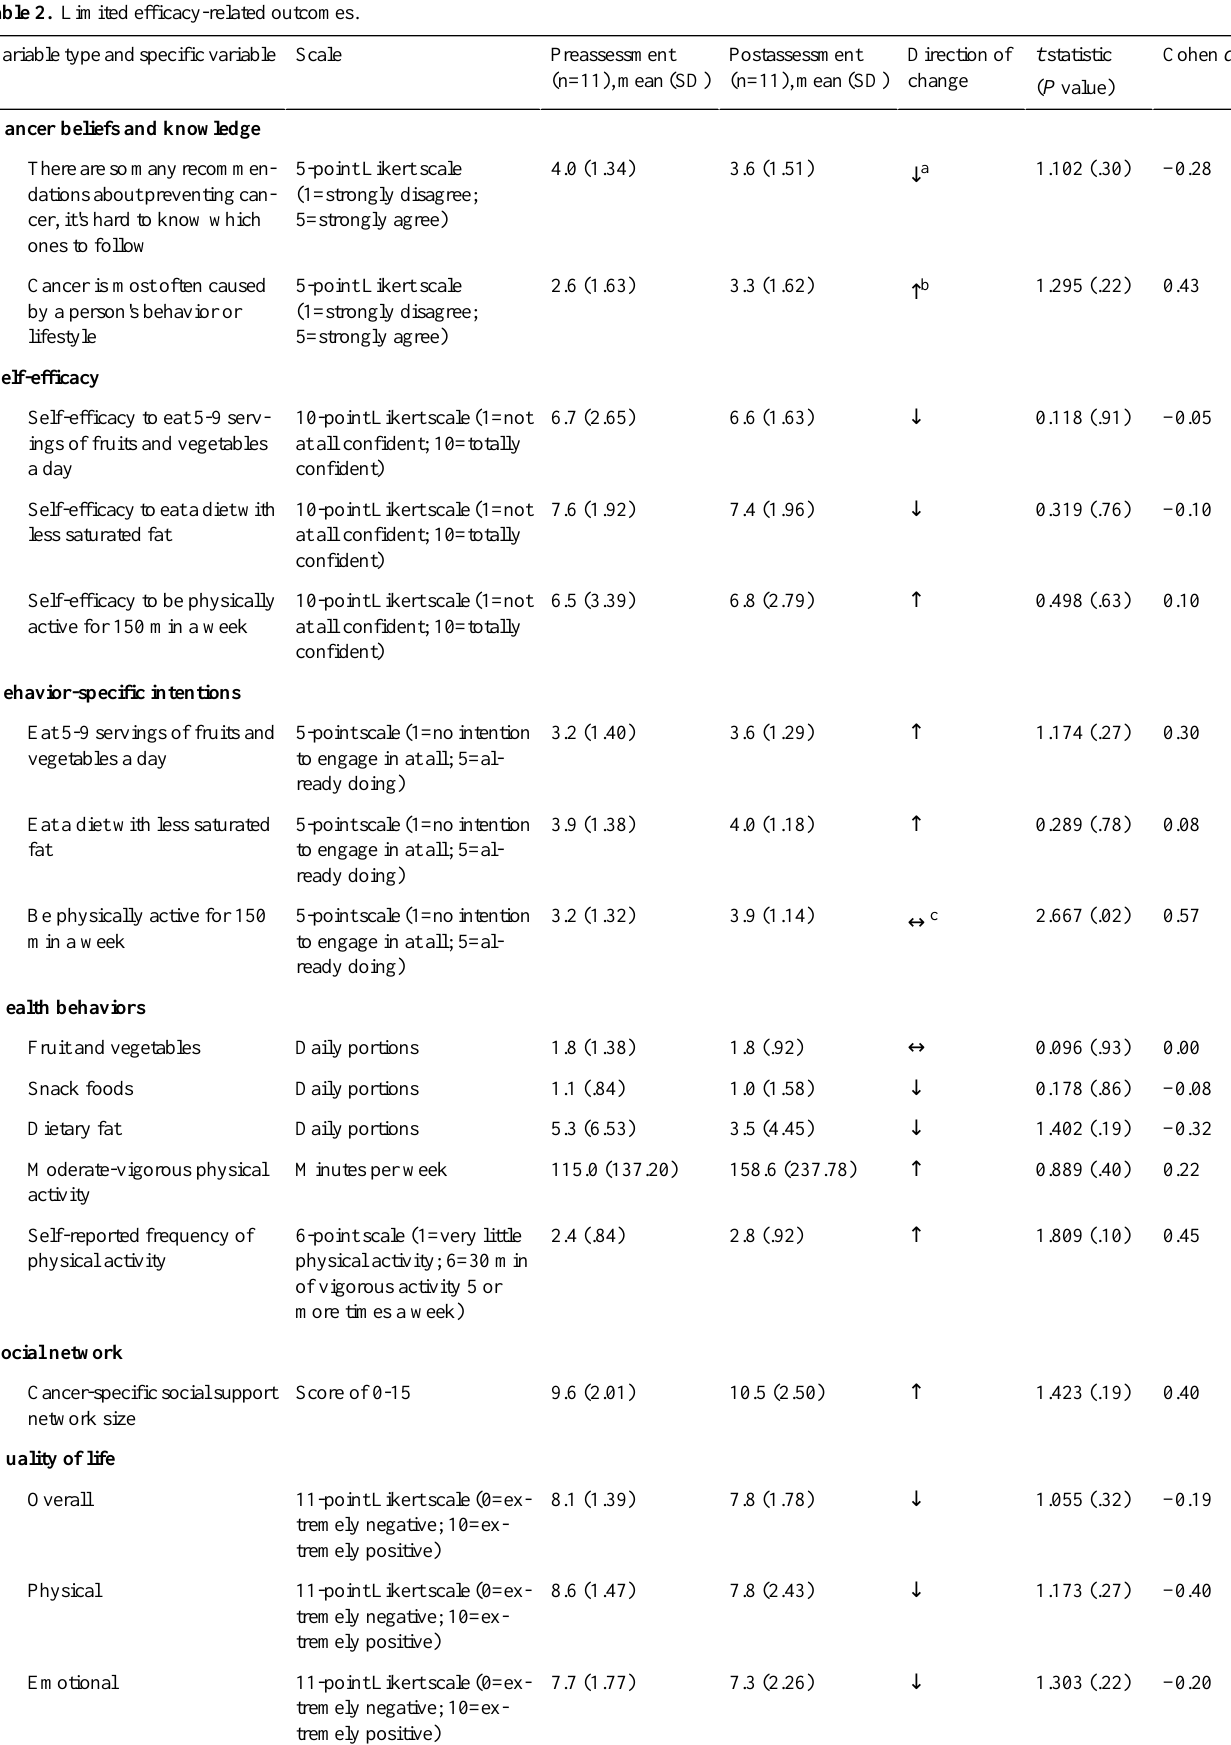
Table 2. Limited efficacy-related outcomes.